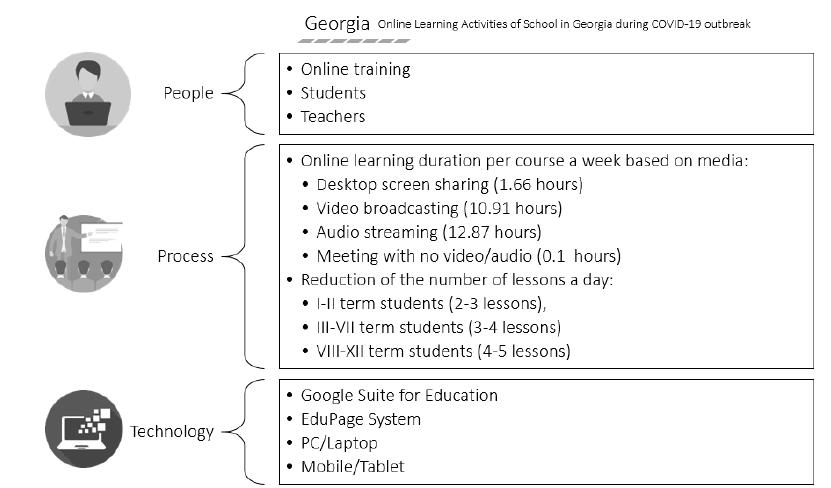
Fig. 5. Online Learning Activities of School in Georgia during COVID-19